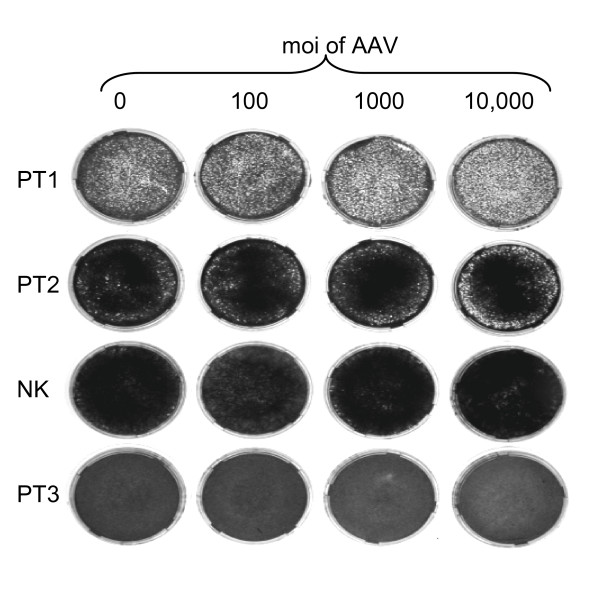
Lack of cytotoxicity by AAV. Various squamous cell isolates were grown in culture and infected with AAV2 virus as indicated. Note that increasing mois of AAV2 did not result in increased cell toxicity of PT3, and had only minimal effects on the cell growth of the other cells. Shown is a representative experiment of three done.